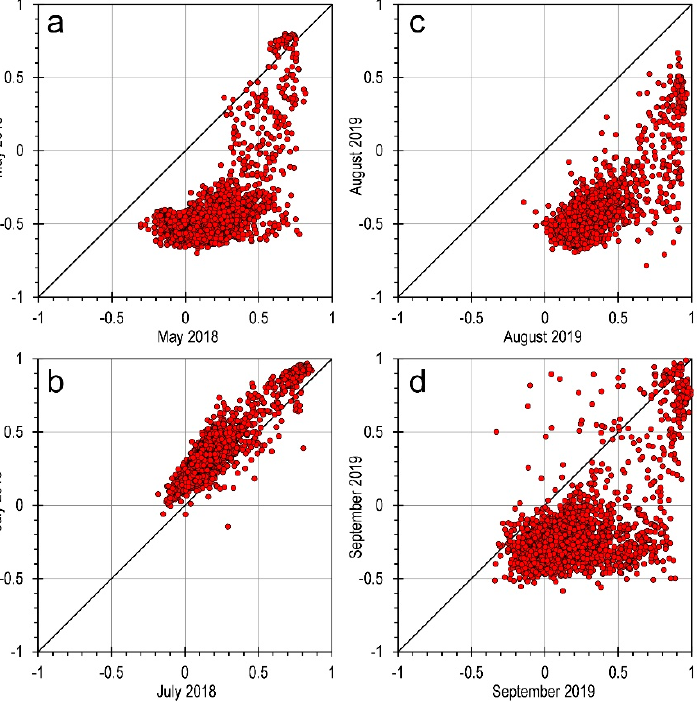
Figure 8. Inter-year comparison of the Modified Normalized Difference Water Index (MDNWI) for 2018 vs. 2019 for May ( a ), July ( b ), August ( c ) and September ( d ).